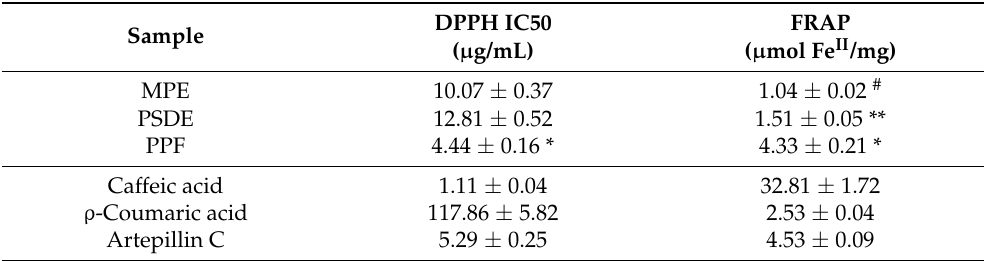
Table 3. Antioxidant activity of the propolis extracts and the propolis biomarker components evaluated using DPPH and FRAP methods. (IC50 = concentration of propolis necessary to reduce the oxidation of DPPH by 50%.